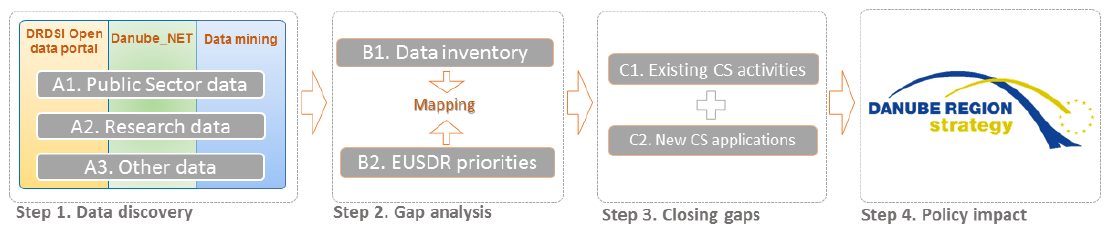
Figure 5. Approach for the identification of possibly contribution of